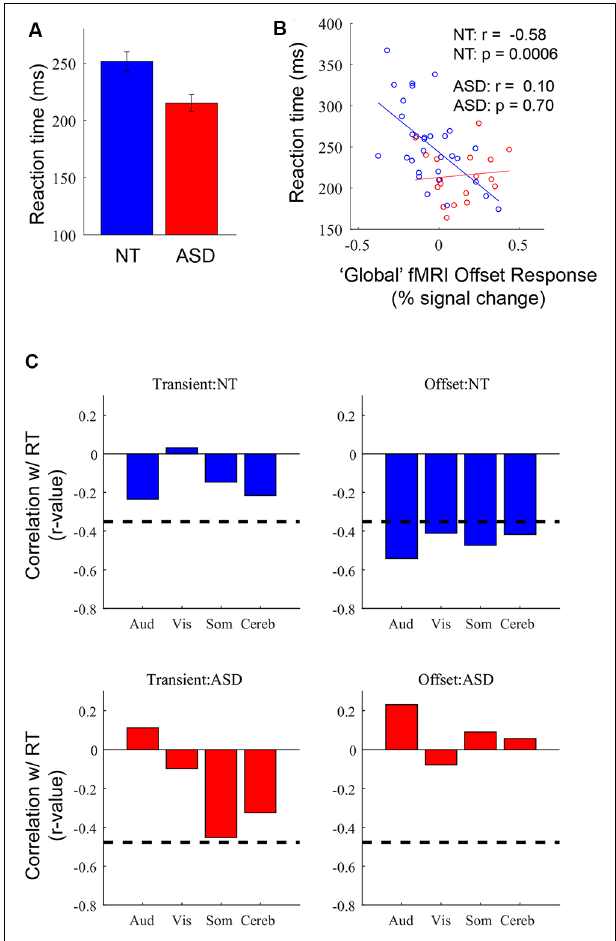
FIGURE 5 | (A) Average reaction time (RT) in NT and ASD participants. (B) Correlation between RT and offset response amplitude averaged across the four ROIs in NT ( n = 32; blue) and ASD ( n = 18; red) participants. (C) Correlations between transient and offset response magnitudes with RT in each of the four ROIs. Dashed line represents p =